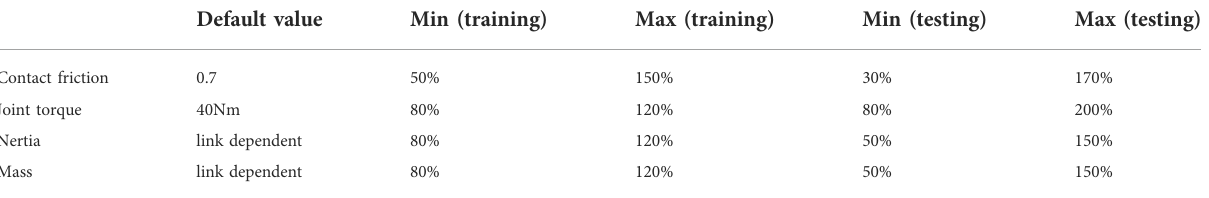
TABLE 1 Variations of dynamics randomisation for